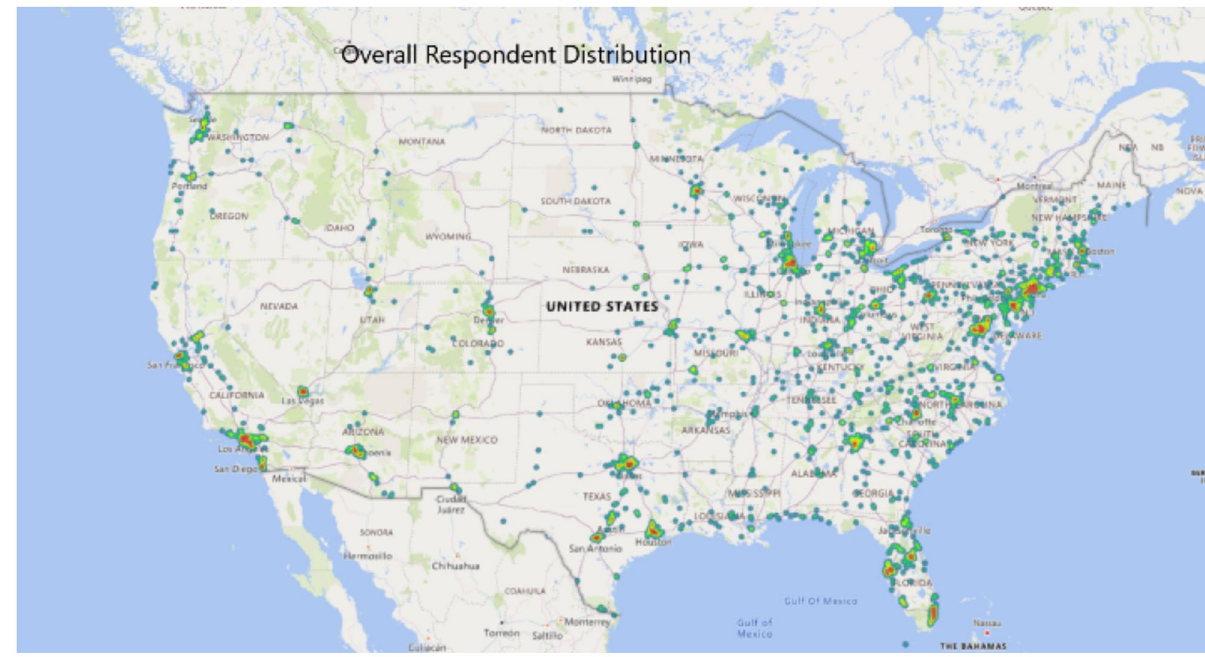
Fig. 2 Location of